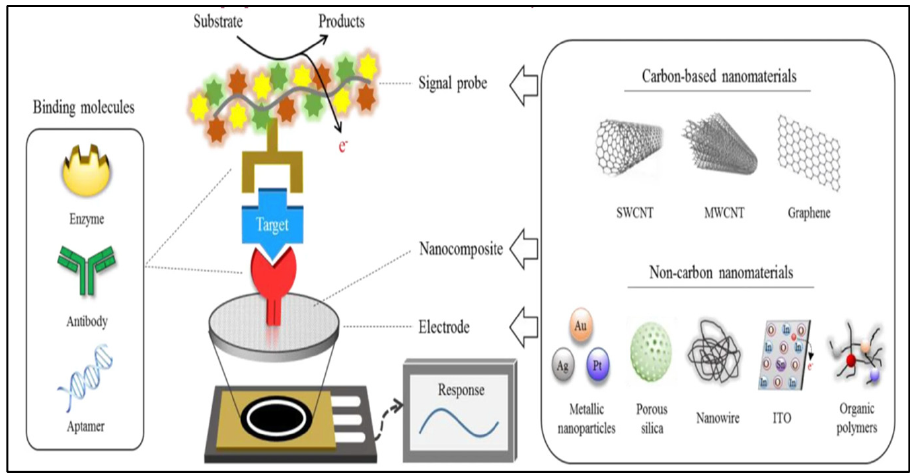
Figure 10. Mechanistic illustration of the principle of electrochemical biosensors based on carbon and non-carbon nanomaterials. Image reprinted with permission from [35], http://creativecommons.org/licenses/by/4.0/, accessed on 26 November